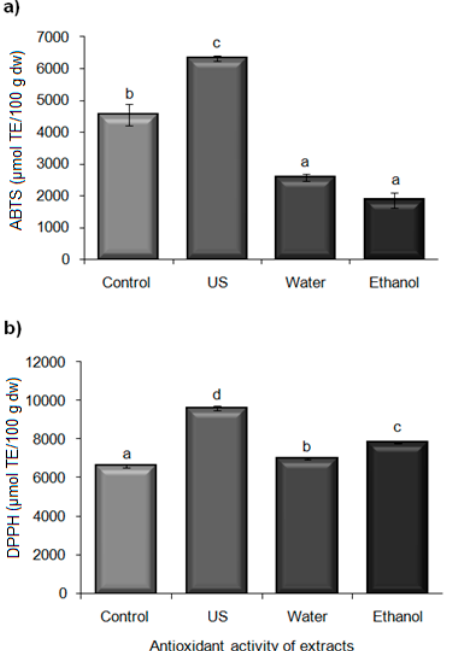
Figure 5. Antioxidant activity of extracts obtained by various methods: ( a ) ABTS (µmol Trolox equivalent/100 g dry weight basis) and ( b ) DPPH (µmol Trolox equivalent/100 g dry weight basis) from blackberry residues. US: ultrasound extraction (91% amplitude by 15 min), Water: aqueous extraction, Ethanol: ethanolic extraction. a–c Different letters indicate a significant difference ( p < 0.05) between methods.